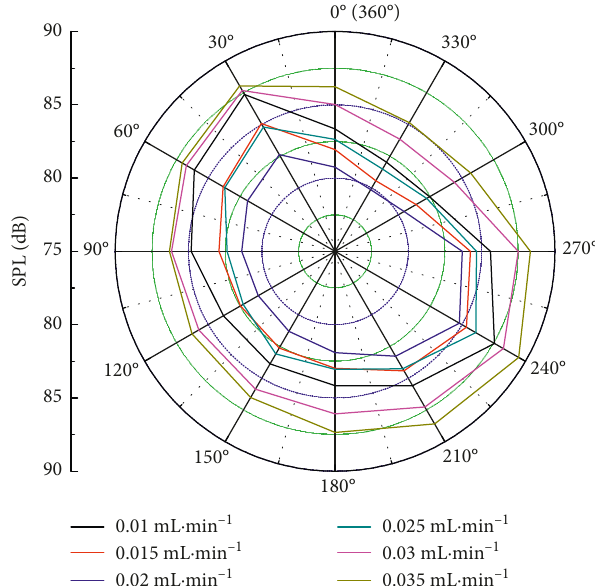
Figure 5: Radiation noise of the ceramic bearing under different oil